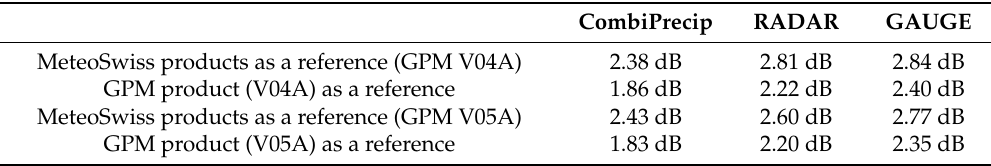
Table 2. Scatter in dB between GPM estimates (versions V04A and V05A) above 221 Swiss sites and the estimates derived from three different MeteoSwiss precipitation